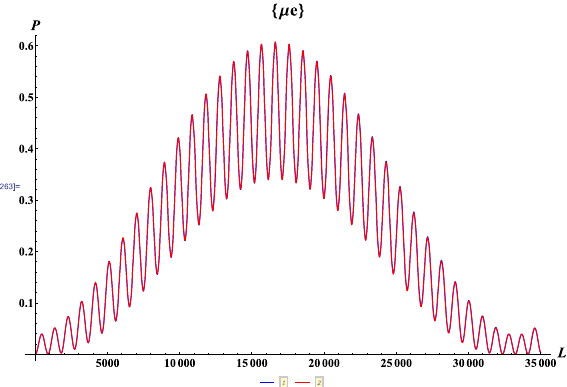
Fig. 7 Same of Fig. 5, but for P ν